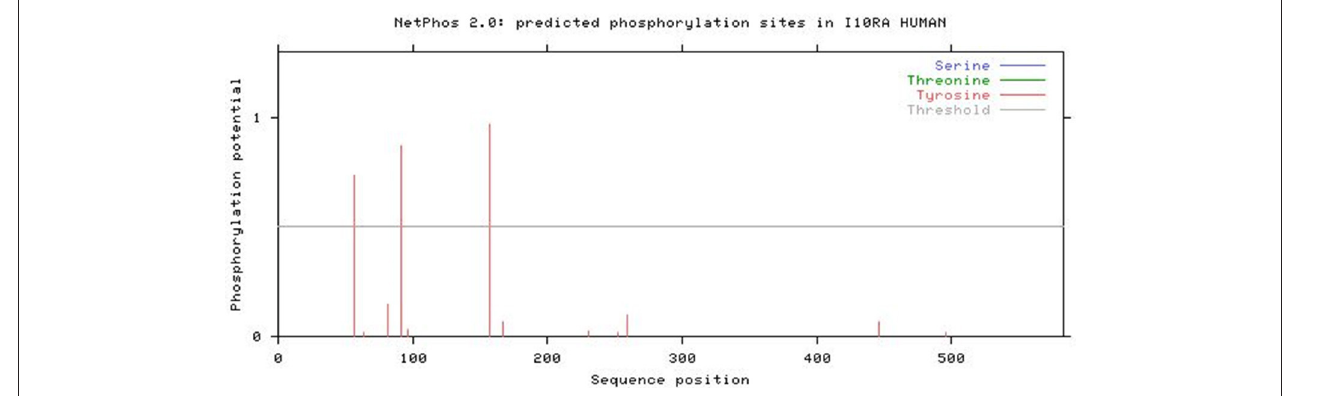
FIGURE 7 | NetPhos 2.0 result showing post-translational